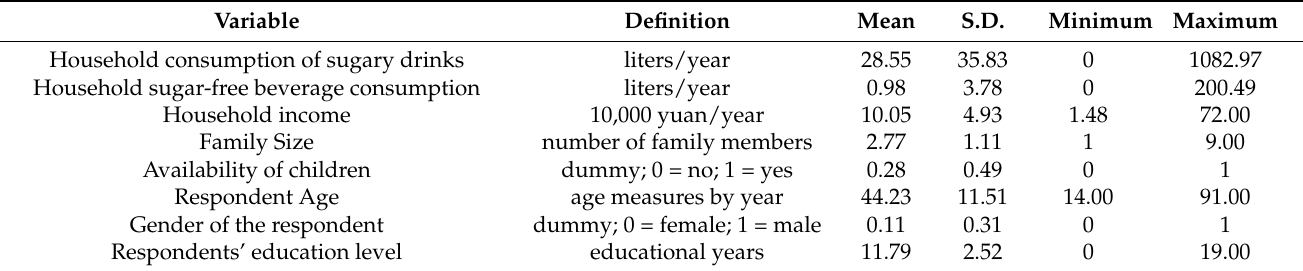
Table 1. Basic characteristics of sample.